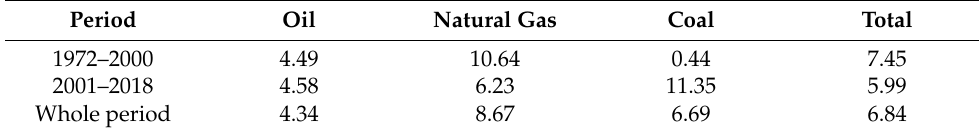
Table 2. Growth rate (%) in total energy consumption in Bangladesh (petajoule). Period Oil Natural Gas